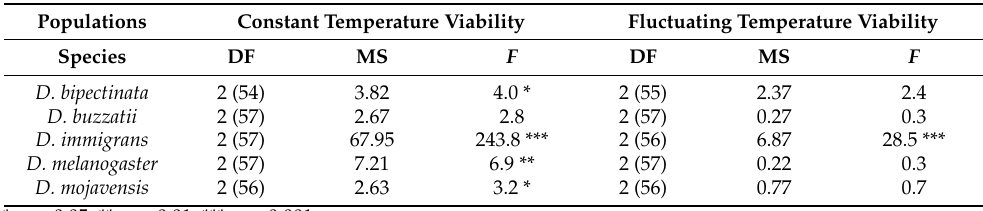
Table 1. Effects of temperature on egg-to-adult viability within species. Separate tests were conducted for the constant (20, 25, and 30 ◦ C) and fluctuating temperature (25 ◦ C CT, small FT and large FT) comparisons. Error DF in